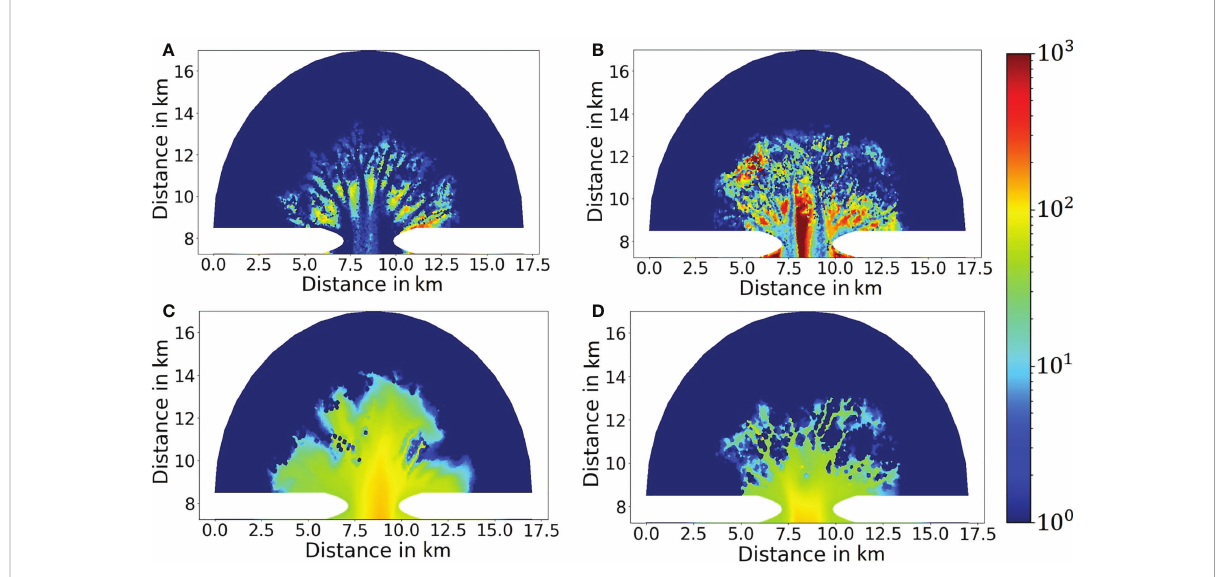
FIGURE 9 Biomass (unit: g C m -2 ) of destabilizing benthos in the Bio_destabilization scenario (A) and the Bio_all scenario (B) . Biomass of fi lter/suspension feeders in the Bio_deposition scenario (C) and the Bio_all scenario (D)